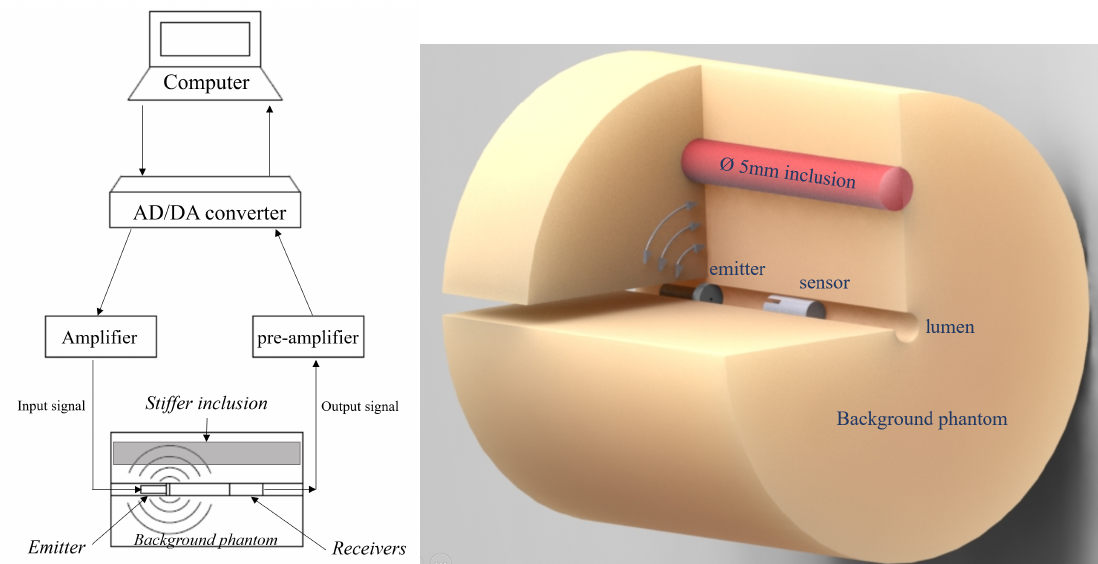
Figure 2. Experimental setup for the transluminal elastography tests. ( Left ): workflow for the transmission and reception, including a computer-controlled AD/DA converter with amplifier stages for both parts. ( Right ): 3D representation of the wave transmission for phantom B (inclusion in red color). Shear waves are pseudospherically transmitted from the emitter to the bulk of the phantom.